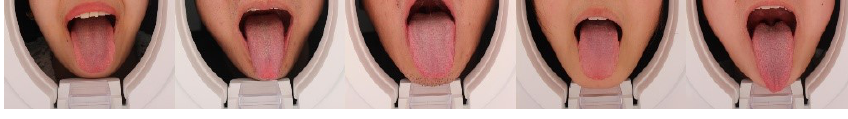
Figure 8. Some samples of dataset 1.